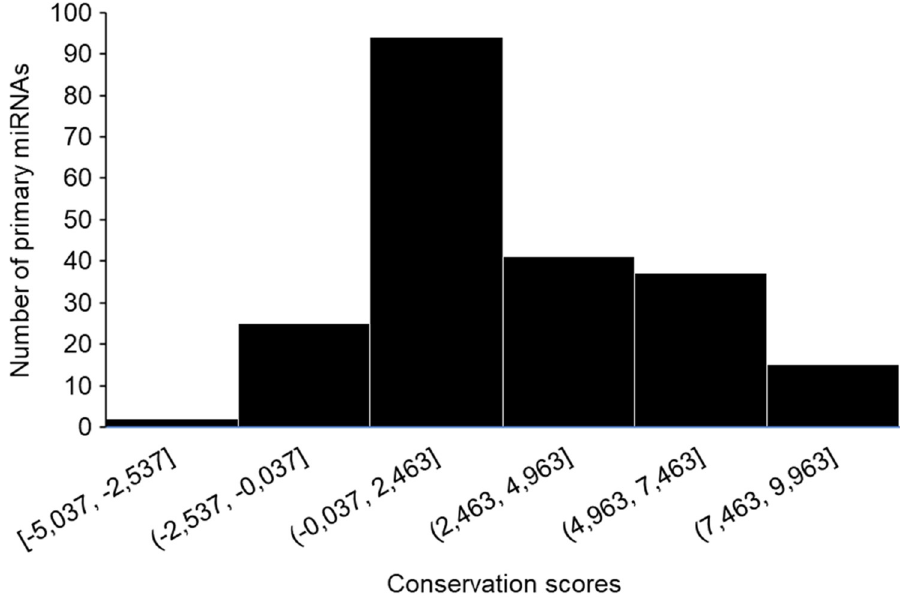
Fig 4. PhyloP conservation scores. Frequency distribuition of PhyloP scores for each SNP position in miRNA sequences. Positive, neutral and negative values are employed to indicate slow, neutral and fast-evolving variations,